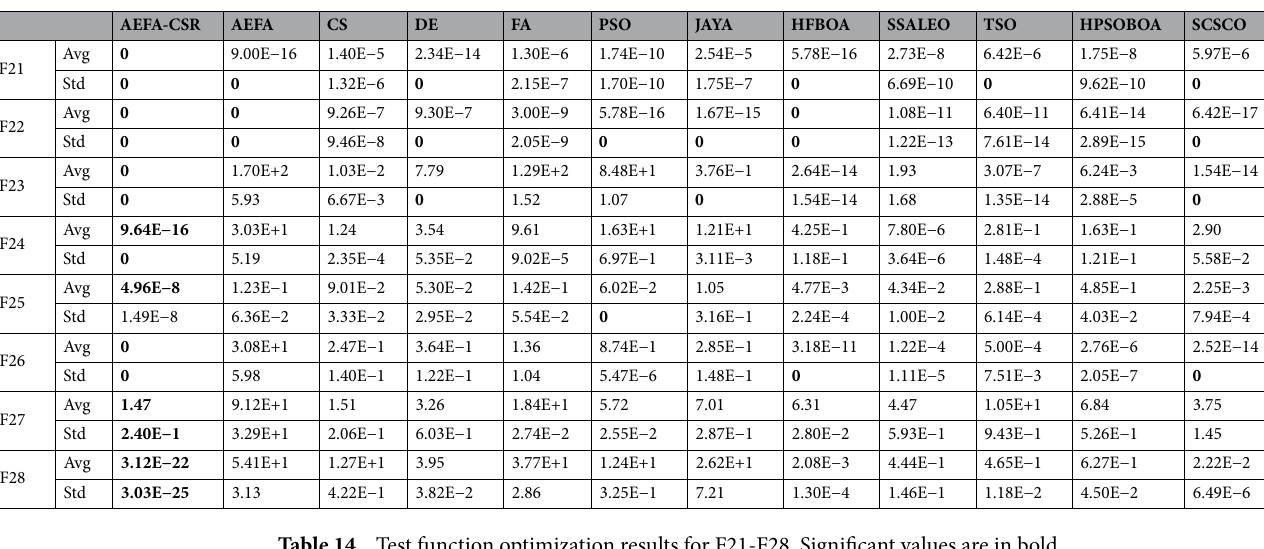
Table 14. Test function optimization results for F21-F28. Significant values are in bold.